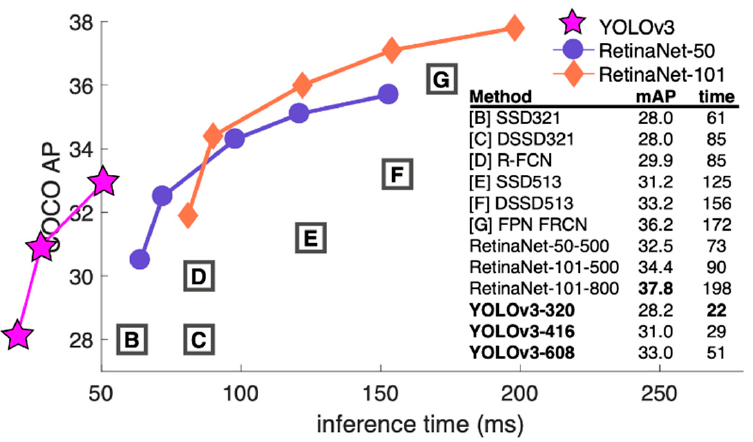
Figure 1. YOLOv3 competes with other detection methods for comparable performance, under the platform either an M40 or Titan X, with essentially the same GPU [17].